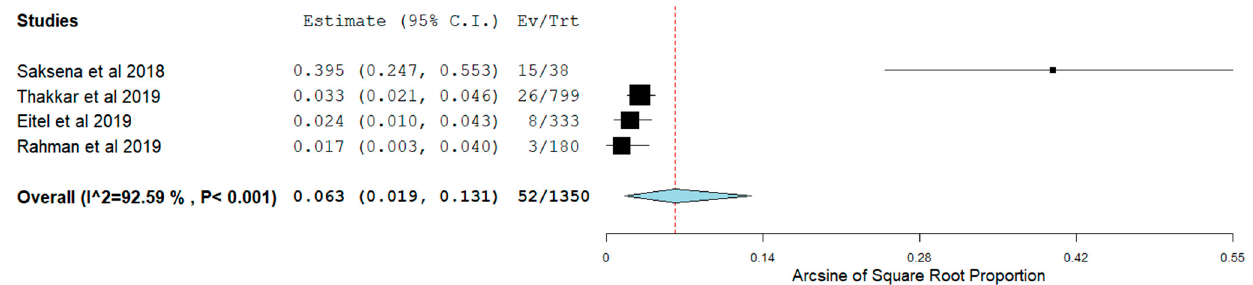
Figure 5. HF admissions in patients with HFpEF.